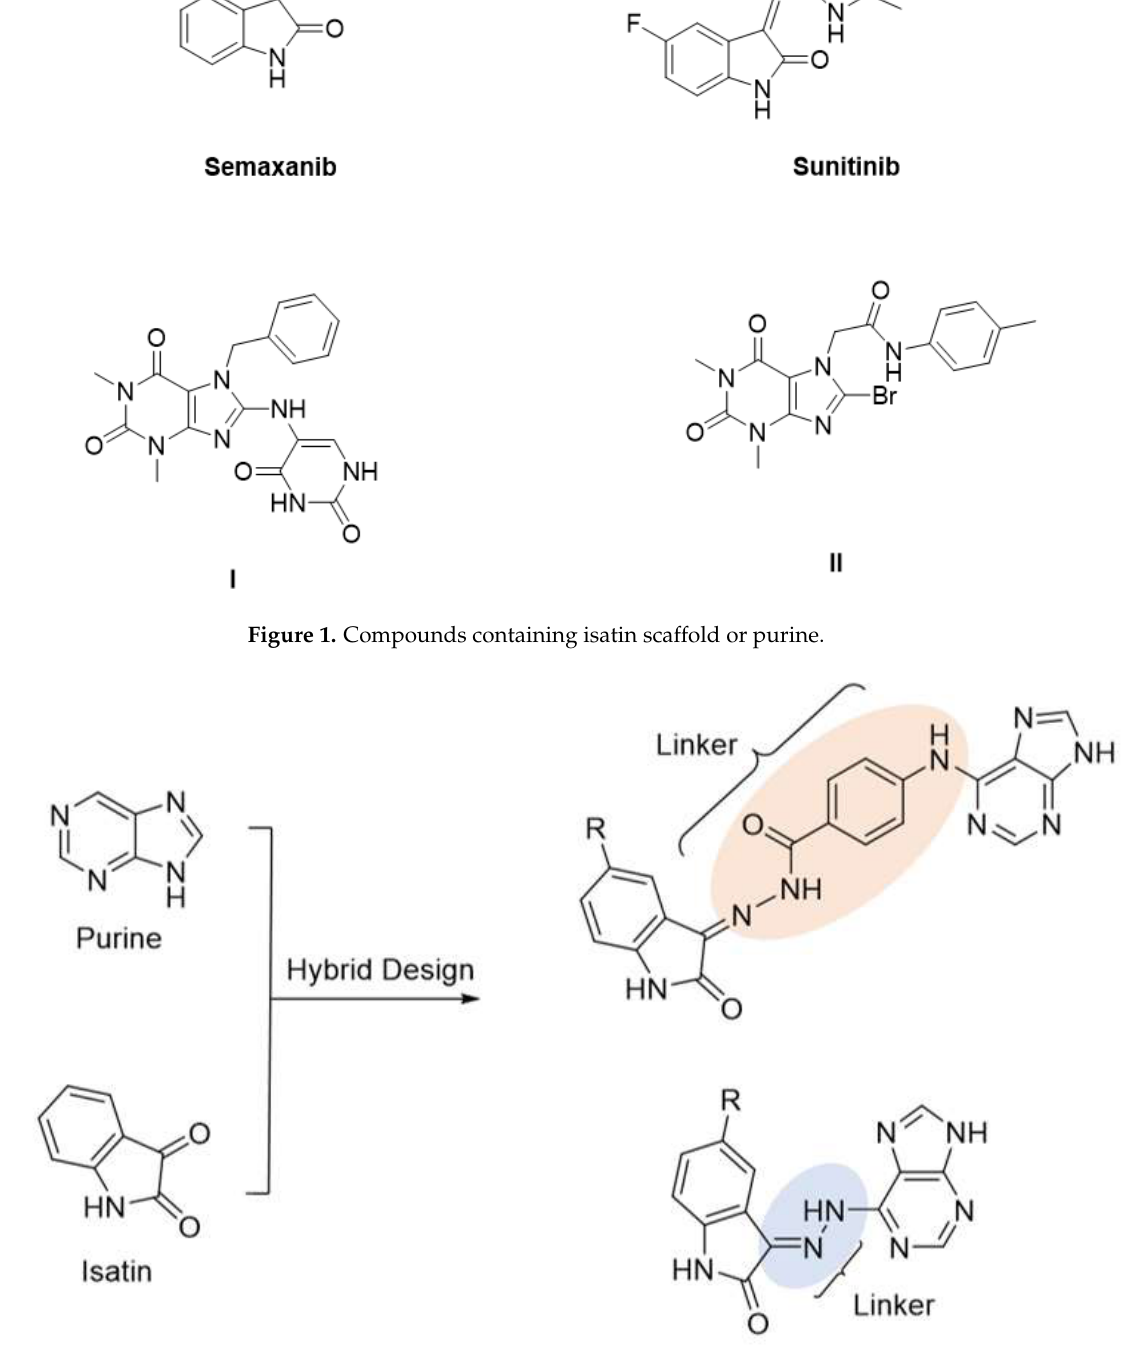
Figure 2. Rational design of isatin–purine hybrid compounds.